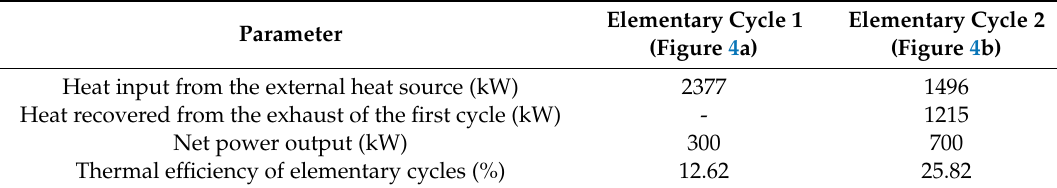
Table 5. Thermal e ffi ciency of the two elementary thermodynamic cycles that compose the partial Table 5. Thermal efficiency of the two elementary thermodynamic cycles that compose the partial heating s-CO 2 power cycle. heating s-CO 2 power cycle.